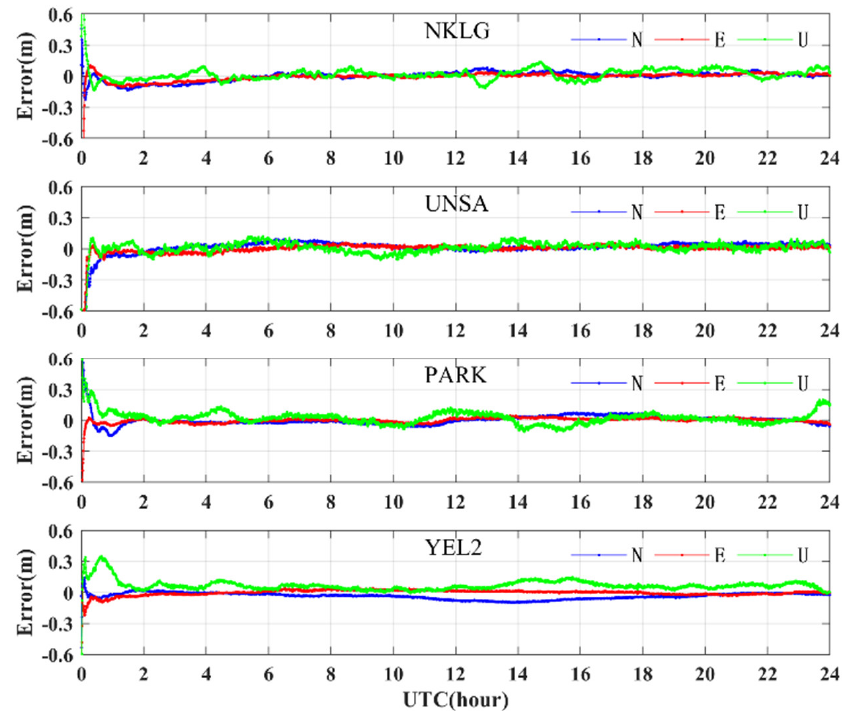
Figure 16. Kinematic PPP results using clock offset estimated in global.